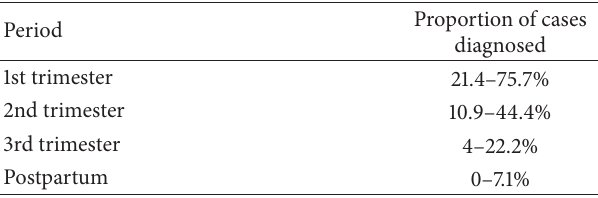
Table 1: Proportion of adnexal masses detected throughout preg- nancy